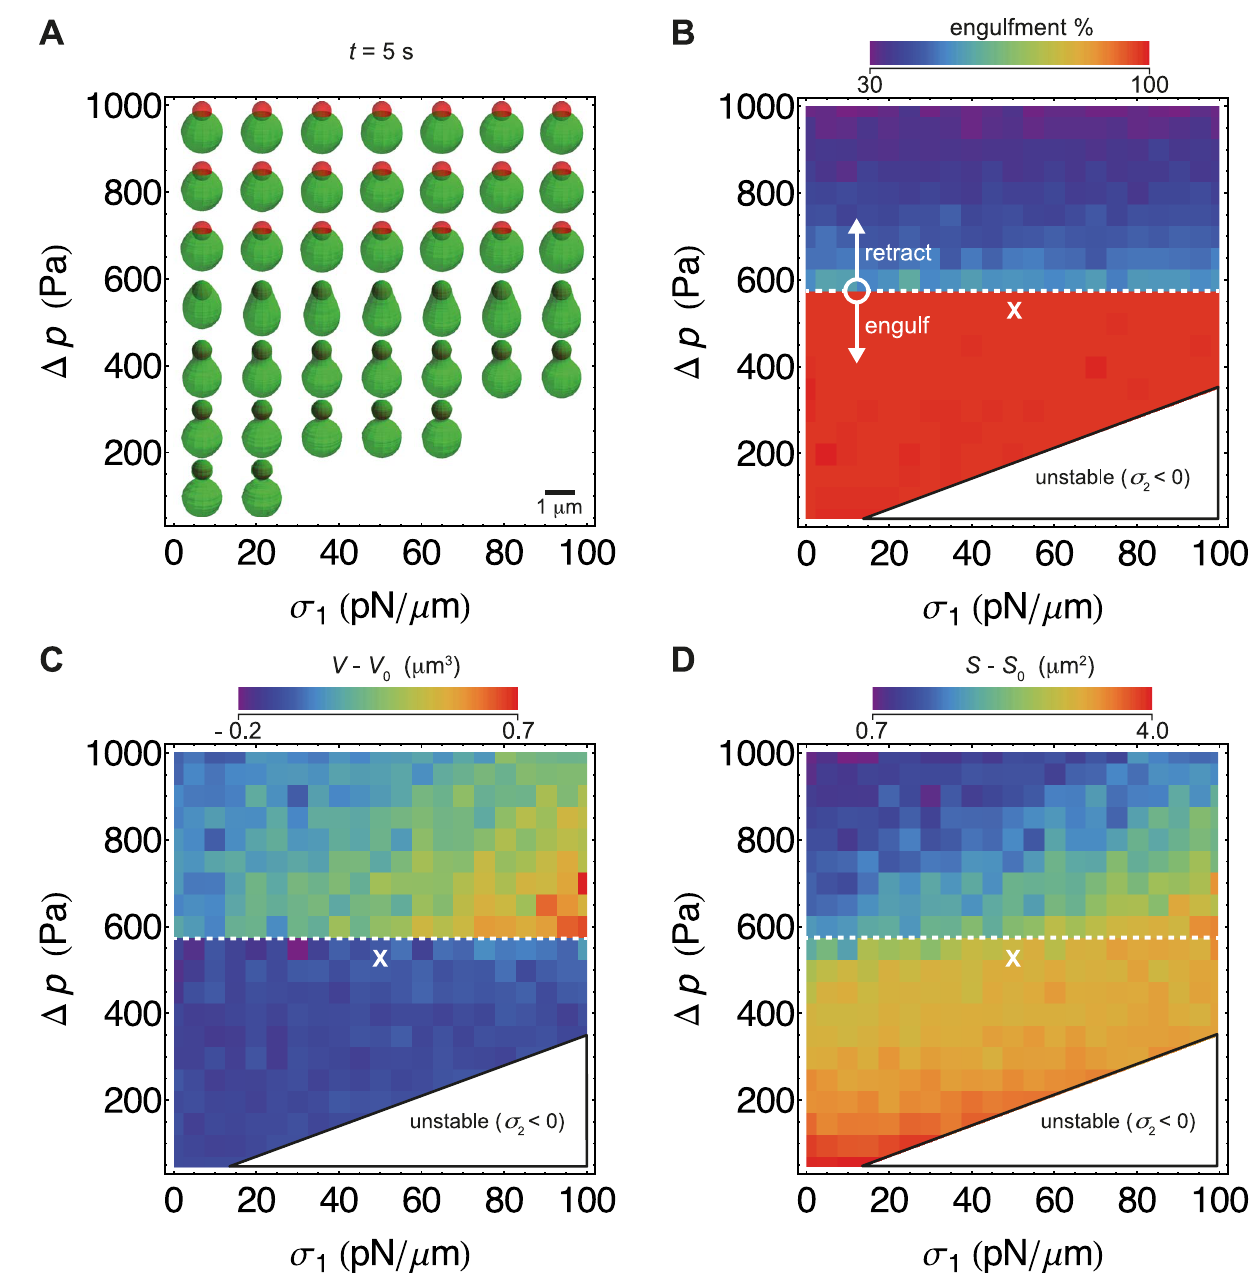
Figure 5. Simulation results for engulfment and volume/surface area changes. (A–D) Simulation snapshots for different parameter combinations for surface tension ( s 1 ) and D p (pressure difference) at 5 s for fixed SpoIIQ-SpoIIIAH surface density r ~ r max ~ 10 4 m m { 2 . Simulations that reached full engulfment earlier than 5 s were terminated and last snapshots are displayed. (B) Percentage of forespore-surface area enclosed by mother membrane. White dashed line separates regions of full and partial engulfment. White cross shows the parameters used for Fig. 6A and B. (C and D) Volume and surface area of mother cell.